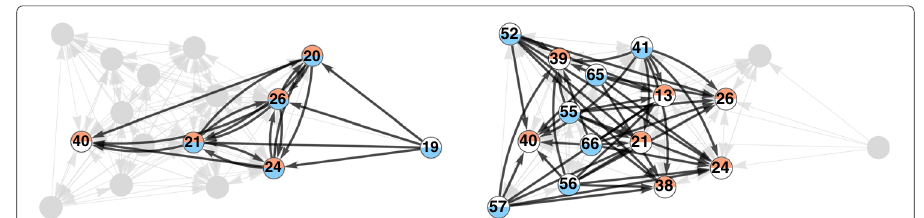
Fig. 7 Two related single pattern and bi-pattern core subgraphs of the lawyers advice network. On the left, the 4-4 HA-core subgraph associated with the single pattern {30 < Age ≤ 50, 5 < Seniority ≤ 20, Gender- Man, Office-Boston}. On the right, the 6-6 BHA-core subgraph associated with the bi-pattern ({25 < Age ≤ 45, Office-Boston, Litigation, Seniority ≤ 5, Associate}, {30 < Age ≤ 60, Office-Boston, Litigation, 5 < Seniority ≤